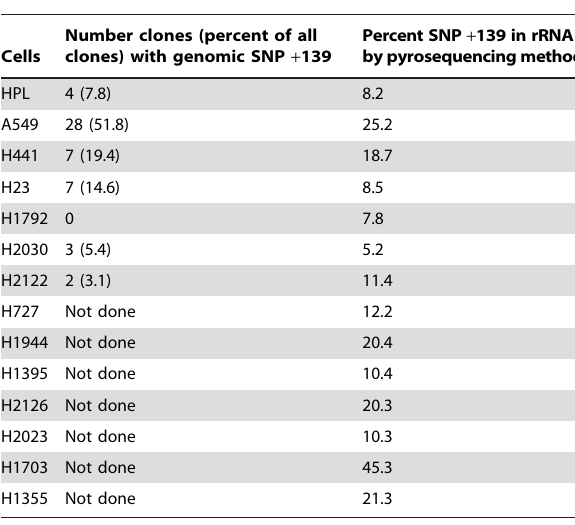
Table 2. Frequency of SNP + 139 by cloning and by pyrosequencing